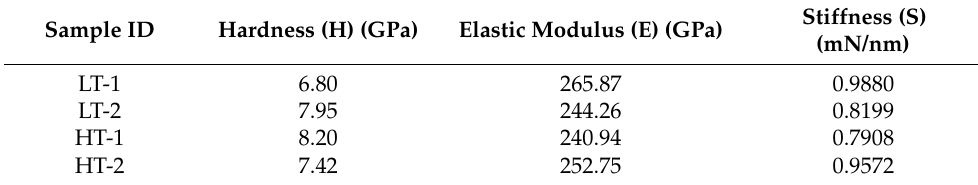
Table 6. Micro-mechanical properties of ballistic steel samples.